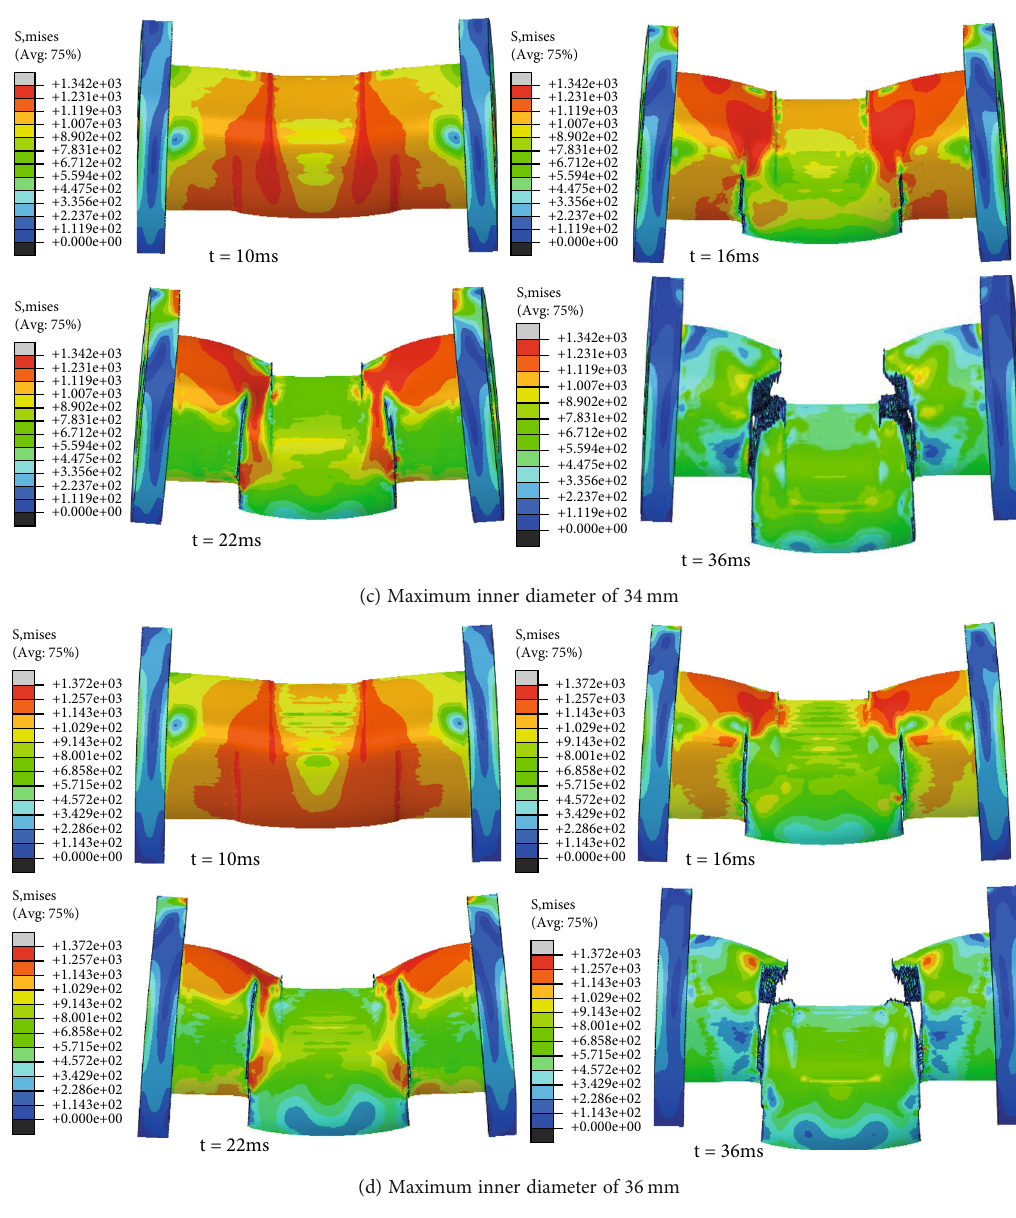
Figure 13: Fracture process of shear pins with di ff erent inner